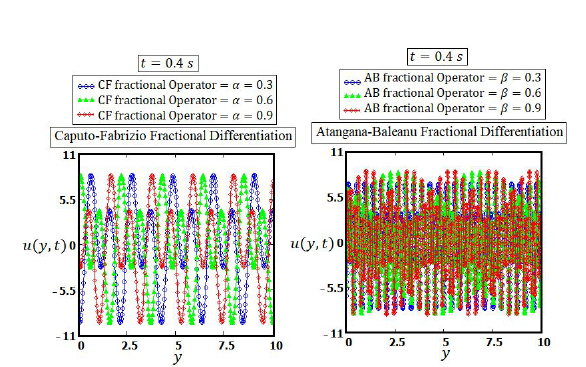
Figure 5: Graph of comparison of displacement via CF and AB frac- tional operator at smaller time t = 0.04 s